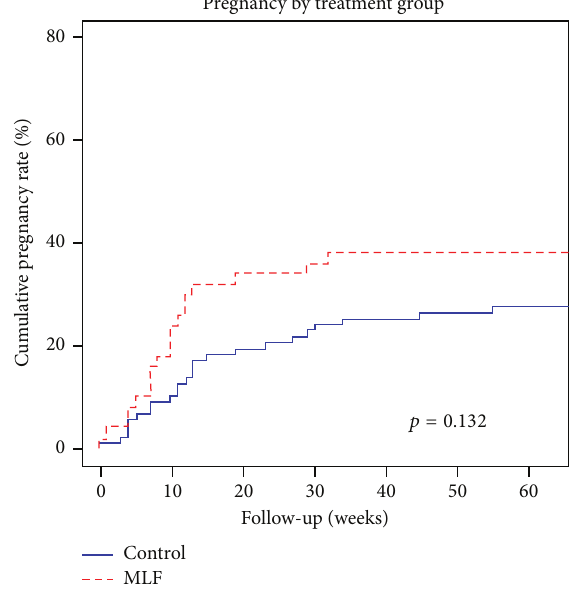
Figure 2: Pregnancy rate for MLF versus control over time ( 𝑝 = 0.13